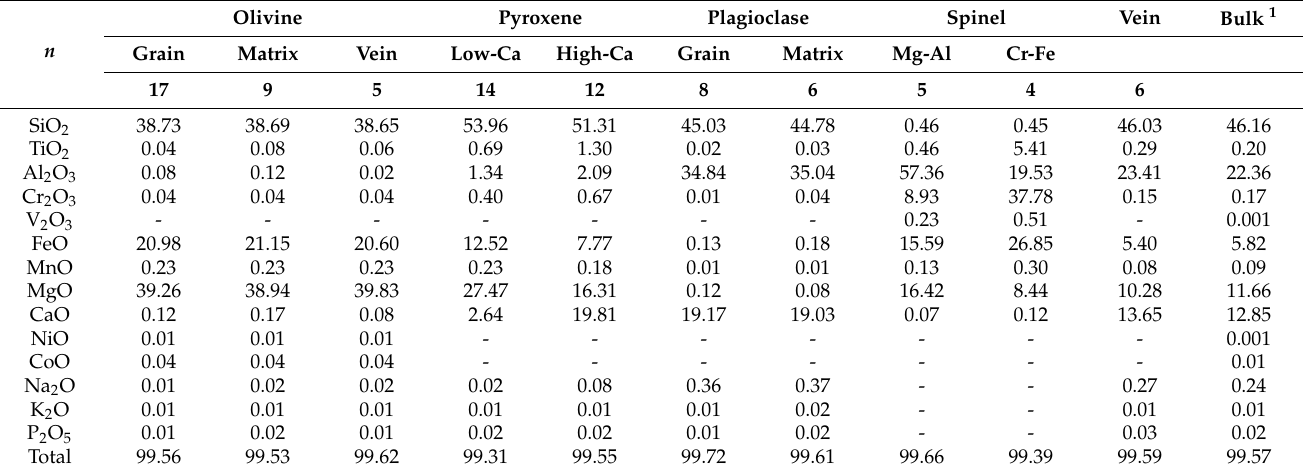
Table 2. Representative EPMA analysis of olivine, pyroxene, plagioclase (or maskelynite), spinel, and impact melt vein, and estimated bulk composition of lunar meteorite NWA 8687 (in